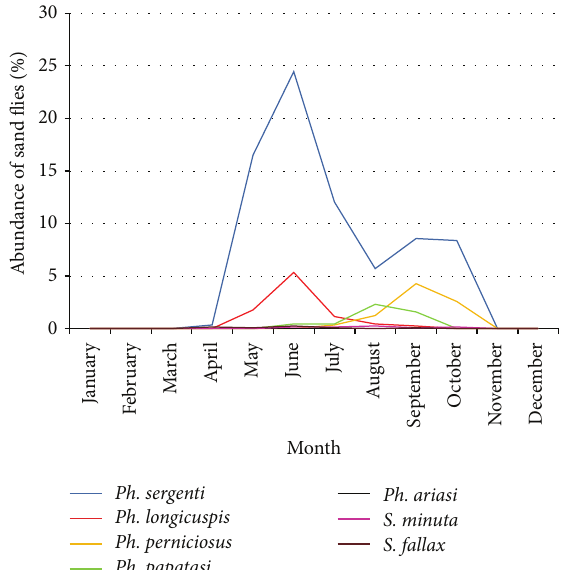
Figure 4: Seasonal distribution of sand flies captured at Aichoun by sticky paper traps from January to December 2011.